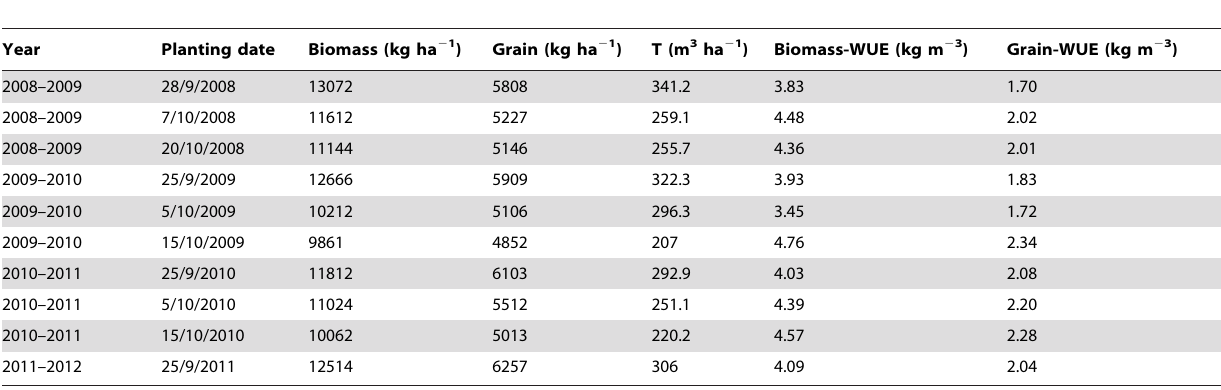
Table 7. Biomass-WUE and Grain-WUE in response to the seasonal transpiration over the different planting dates across years at Xiaotangshan experimental